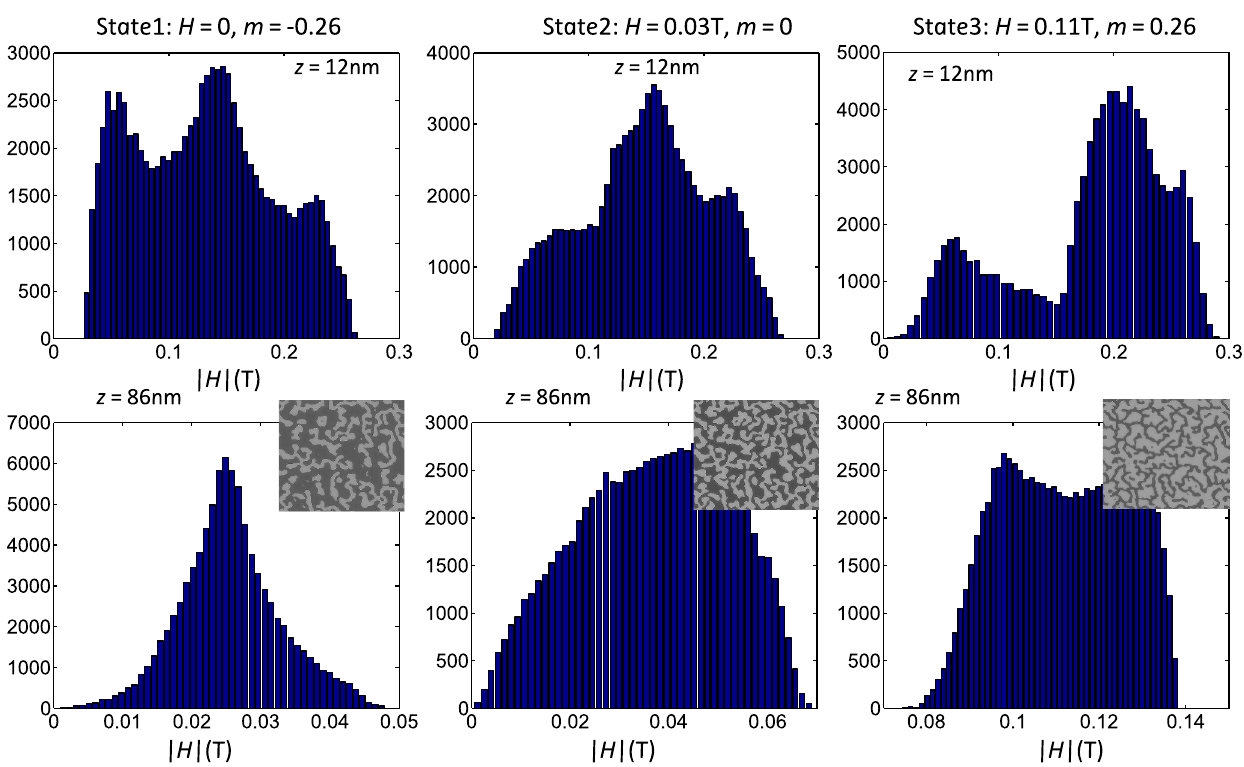
FIG. 15. Histograms (probability distribution) of the fringe fields plus the externally applied field, j H j , from a magnetic electrode. Three states are shown; the values for H and m are approximate. The histograms correspond to magnetic fields at (row 1) 12 nm and (row 2) 86 nm from the ferromagnetic electrode, respectively. The grey insets are XMCD images of the magnetic domain structure which are 3 (cid:1) 3 (cid:1) m 2 .